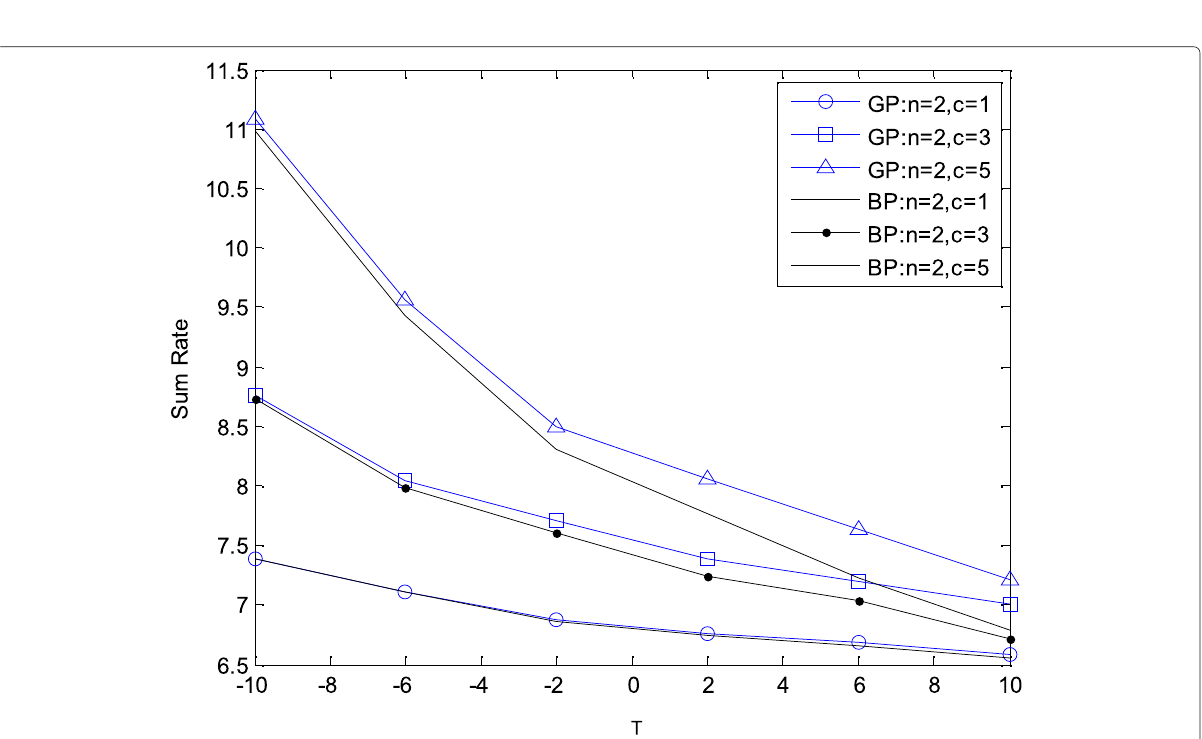
Fig. 12 Sum rate of the centralized algorithms vs. SINR